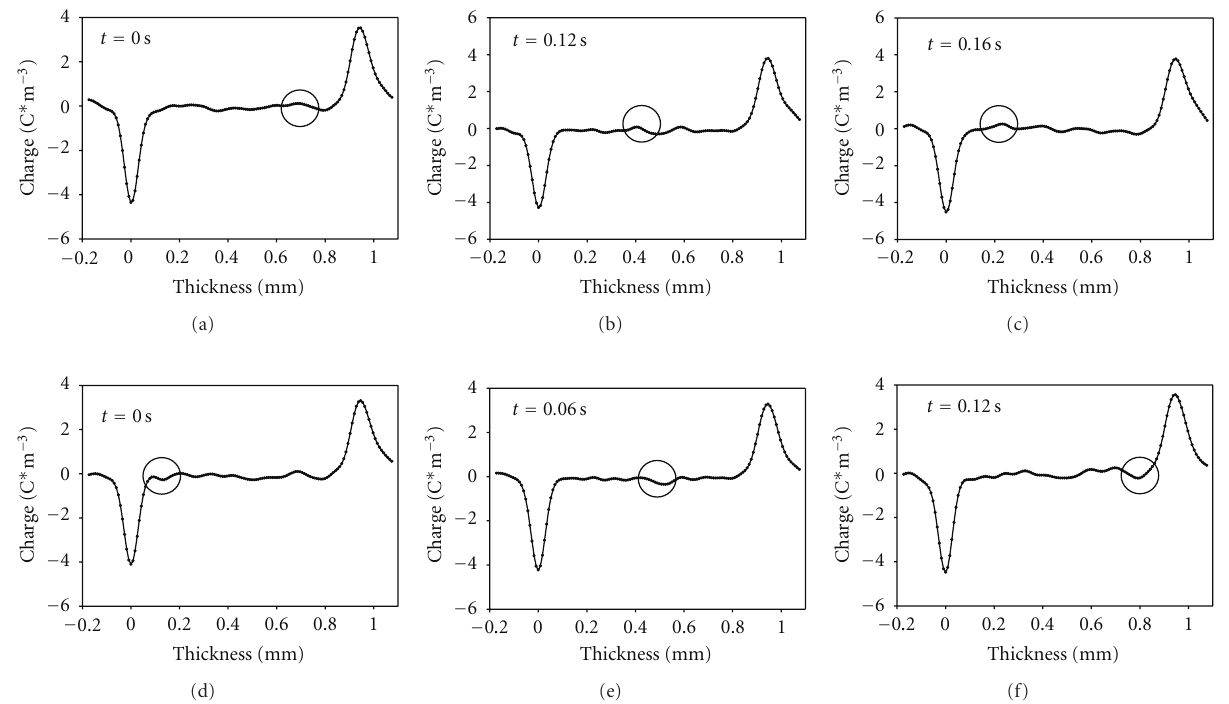
Figure 5: Evolution of charge profiles in specimen no. 5 under an electrical field of 10 kV/mm and temperature of 70 ◦ C for a positive charge pulse (a)–(c) and a negative charge pulse (d)–(f).